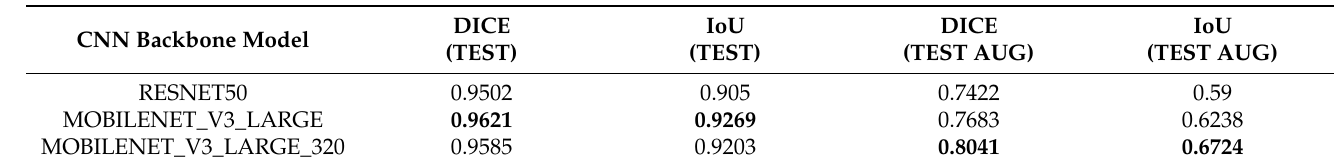
Table 4. Faster R-CNN backbone models’ DICE and IoU scores on TEST and TEST AUG set. Proba- bility threshold 0.5 (50%). Best results are bold.